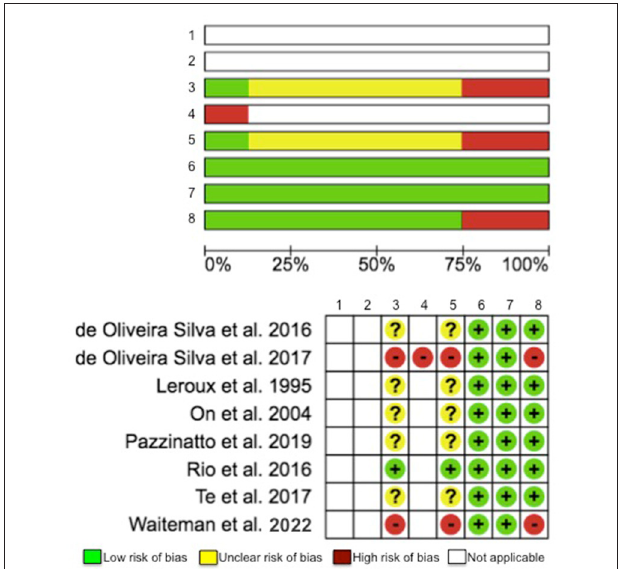
FIGURE 2 | Risk-of-bias assessment for evaluating following items: (1) Random sequence generation (selection bias), (2) Allocation concealment (selection bias), (3) Blinding of participants and personnel (performance bias), (4) Blinding of outcome assessment (detection bias): self-reported outcomes, (5) Blinding of outcome assessment (detection bias): objective measures, (6) Incomplete outcome data (attrition bias), (7) Selective reporting (reporting bias), and (8) No asymptomatic control group (other